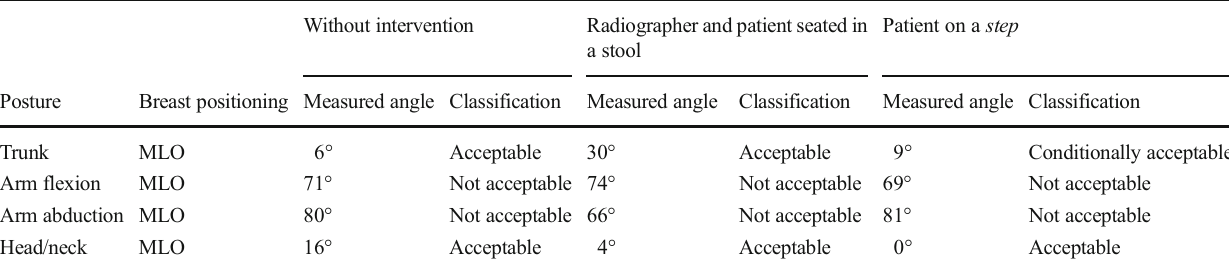
MLO breast positioning: postures for radiographer smaller than the patient without and with postural interventions Without intervention